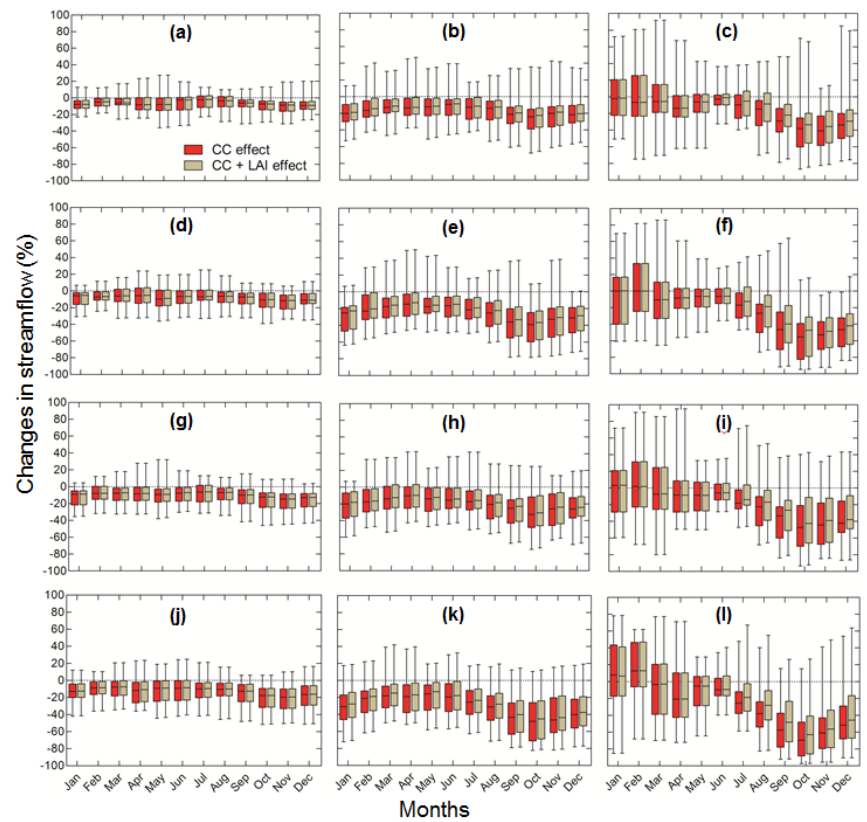
Figure 10. Box plots of impacts on mean monthly streamflow from 38 CMIP5 runs of catchment 6 ( a , d , g and j ), catchment 10 ( b , e , h and k ), and catchment 11 ( c , f , i and l ) of projected climate change for future periods 2021–2050 and 2071–2100 under RCP4.5 and RCP8.5 respectively, relative to the 1981–2010 base period. CC effect indicates precipitation and temperature effect with unchanged LAI; CC + LAI effect indicates precipitation, temperature and LAI effect. The lower boundary of the box indicates the 25th percentile, a line within the box marks the median, the upper boundary of the box indicates the 75th percentile and the whiskers are delimited by the maximum and